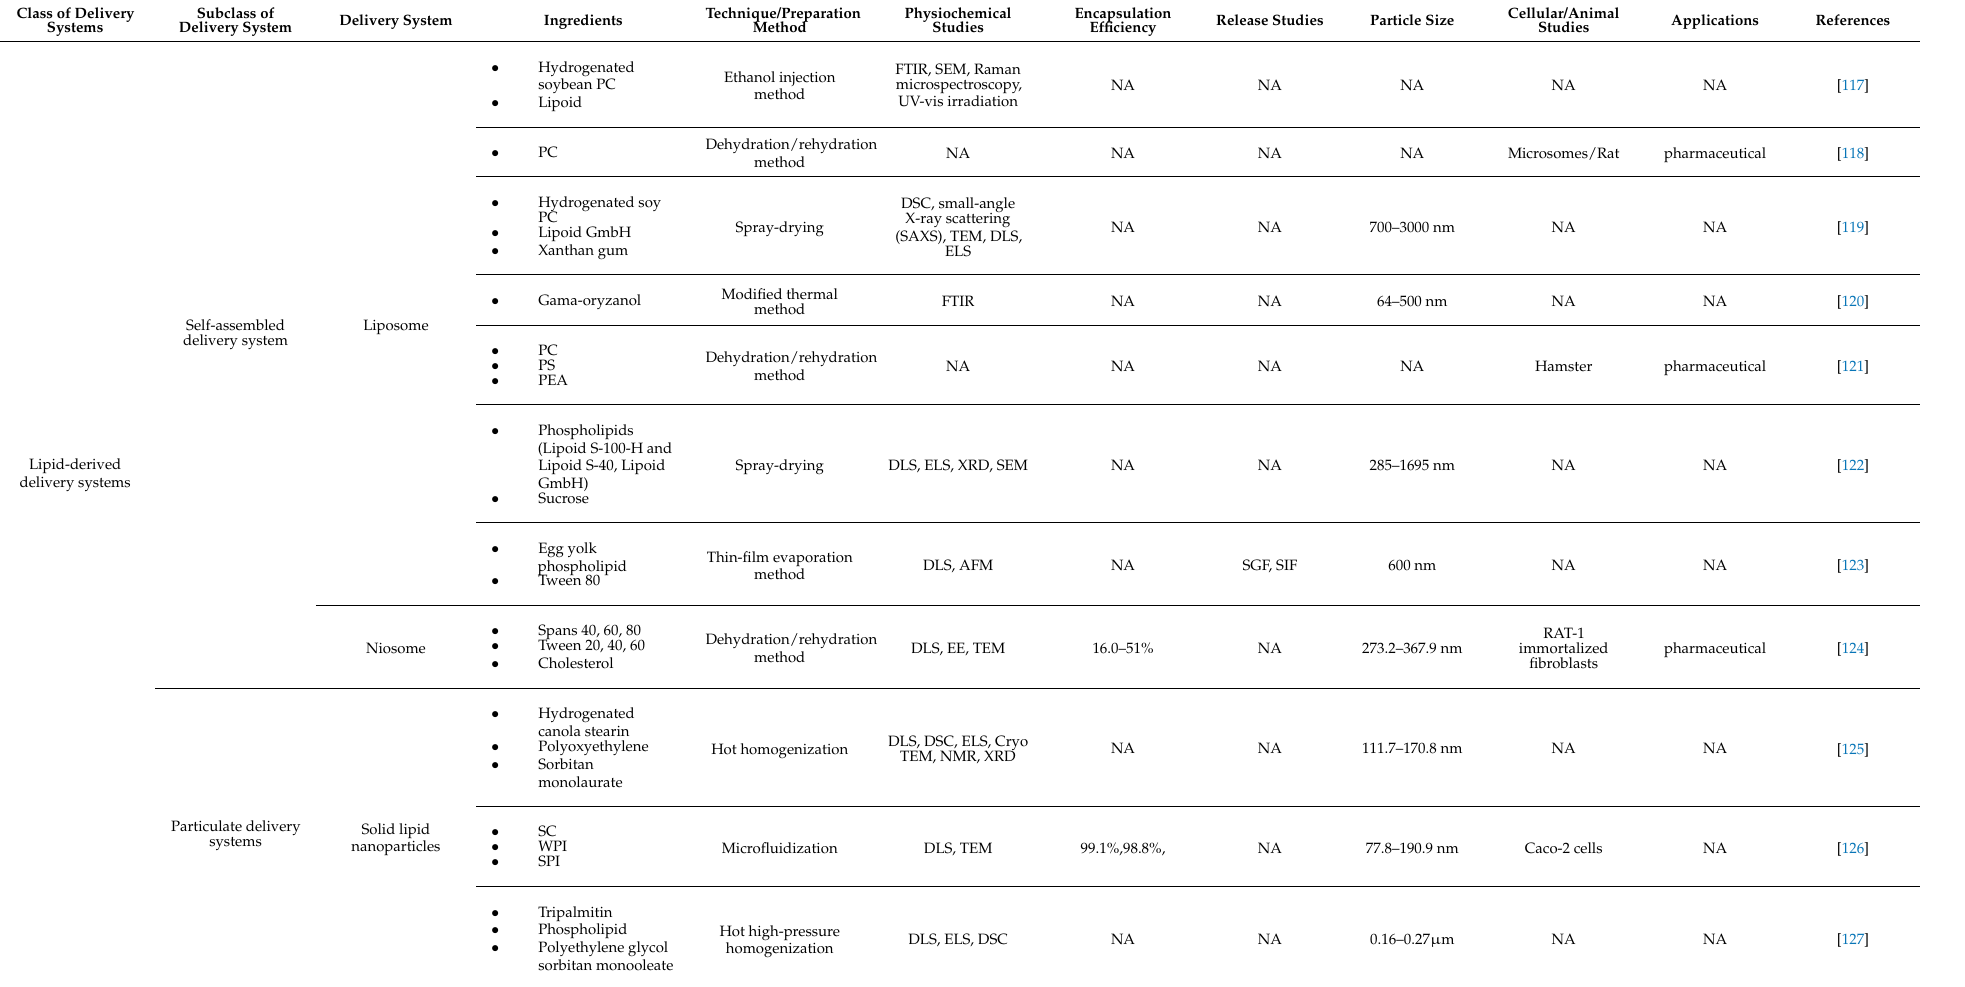
Table 1. Engineered nanoparticle-based delivery systems for enhancing the bioavailability of β